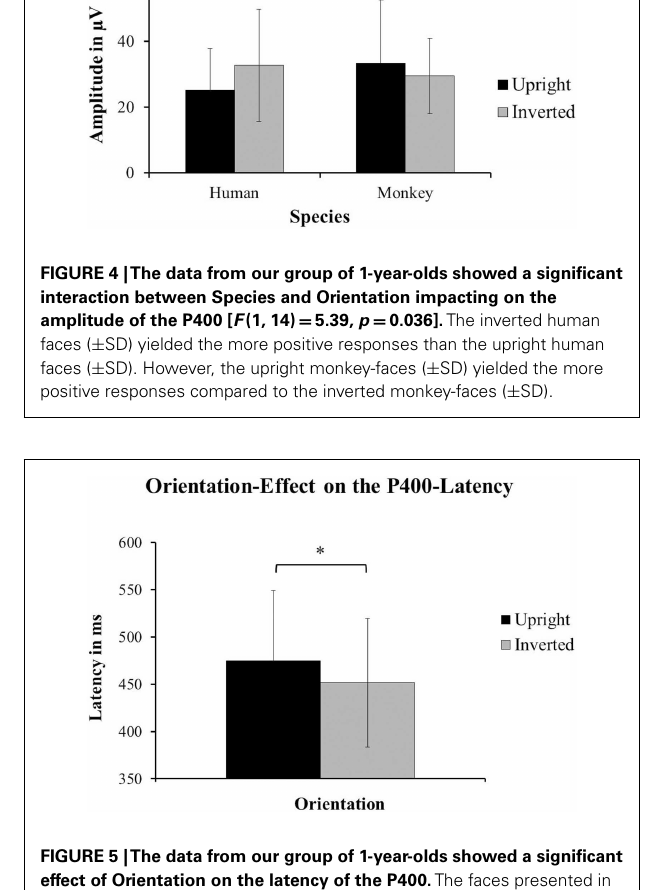
FIGURE 5 |The data from our group of 1-year-olds showed a significant effect of Orientation on the latency of the P400. The faces presented in an upright orientation ( ± SD) had significantly longer latencies for the P400 than the inverted faces [ ± SD; F (1, 14) = 6.22, p = 0.026].This effect was found irrespective of